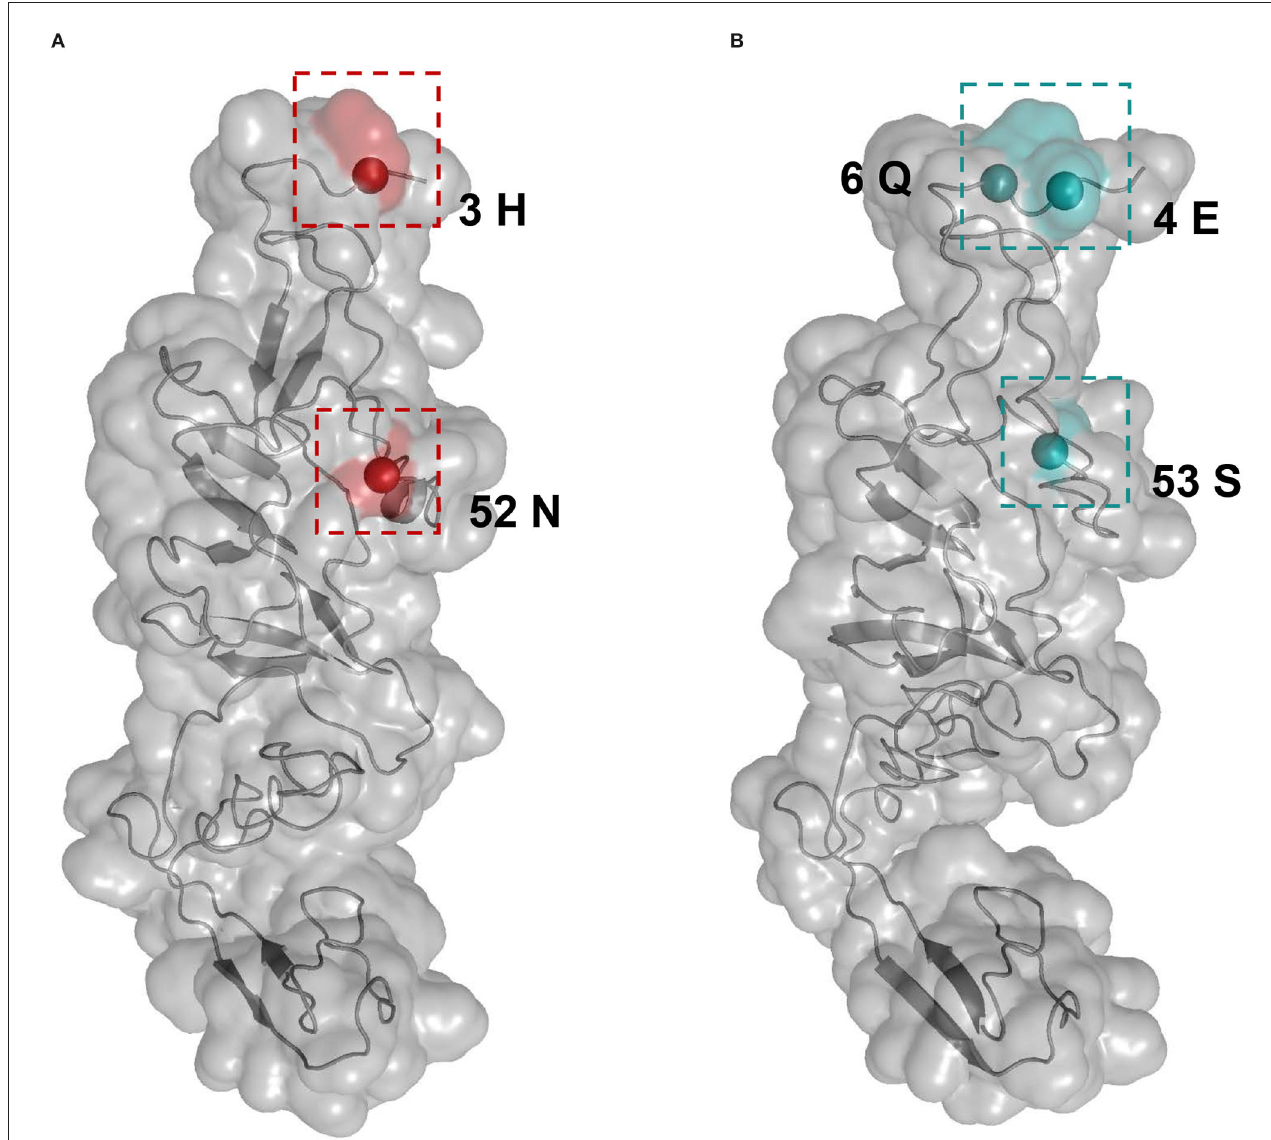
FIGURE 6 | Structural mapping of positively selected sites on the E2 protein. The tertiary structures of E2 monomers were predicted using I-TASSER. (A) The model for lineage 1 (Strain: KX929063) was supported with C-score = − 1.41 and TM-score = 0.54 ± 0.15. Red colors indicate the residues 3 and 52 from lineage 1. (B) The model for lineage 4 (Strain: ON036562) was supported with C-score = − 1.45 and TM-score = 0.54 ± 0.15. Blue colors indicate the residues 4, 6, and 53 from lineage